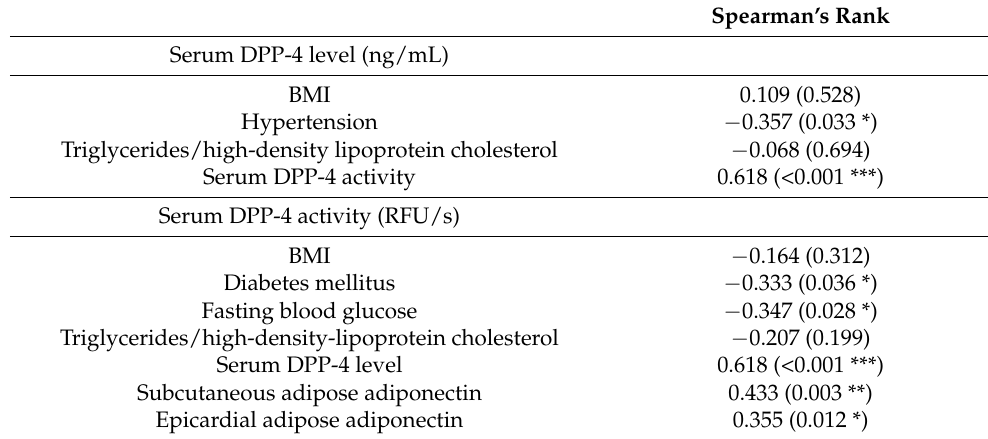
Figure 2. Correlations between ( a ) serum DPP-4 and serum DPP-4 activity, ( b ) serum and SAT DPP-4, ( c ) serum and EAT DPP-4, ( d ) serum DPP-4 activity and SAT DPP-4, ( e ) serum DPP-4 activity and EAT DPP-4, and ( f ) SAT and EAT DPP-4. Table 2. Correlation between DPP-4 and other parameters in serum, subcutaneous adipose tissue, and epicardial adipose